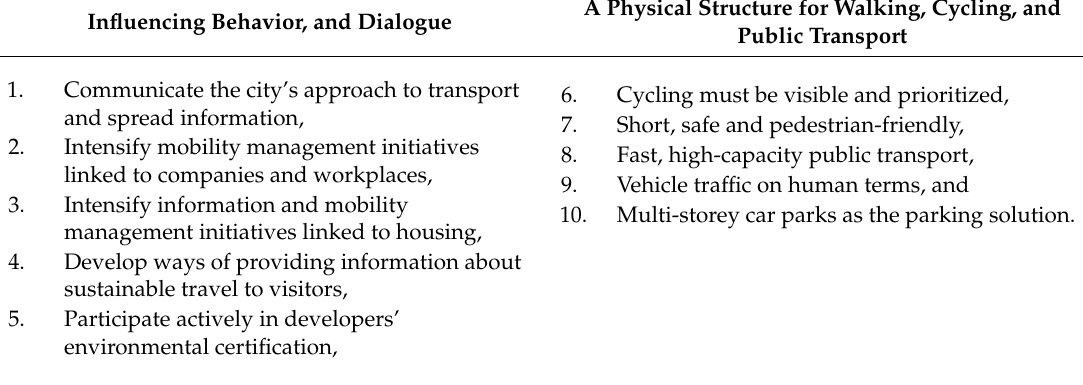
Table 5. Ten initiatives in influencing behavior and shaping physical structure. Source: Malmö City (2015) [69].